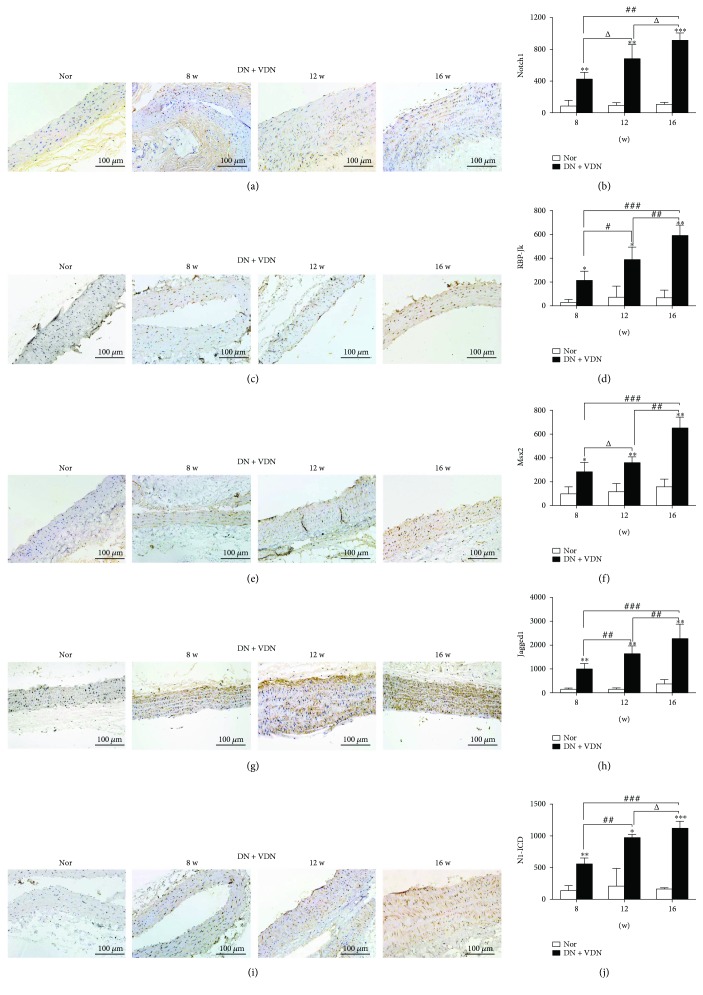
Detection of Notch1, RBP-Jk, Msx2, Jagged1, and N1-ICD levels by immunohistochemical analysis. The representative images and quantitative analysis of Notch1 (a-b), RBP-Jk (c-d), Msx2 (e-f), Jagged1 (g-h), and N1-ICD (i-j) in aortic tissues. The left panel of histological images: Nor group; right panel: DN + VDN group at 8, 12 , and 16 weeks, respectively. Data presented as mean ± standard deviation (SD). ∗p < 0.05, ∗∗p < 0.01, and ∗∗∗p < 0.001 versus Nor group; Δp > 0.05, #p < 0.05, ##p < 0.01, and ###p < 0.001. Nor group: normal controls; DN + VDN group: diabetic nephropathy rats with vitamin D3/nicotine-induced vascular calcification.